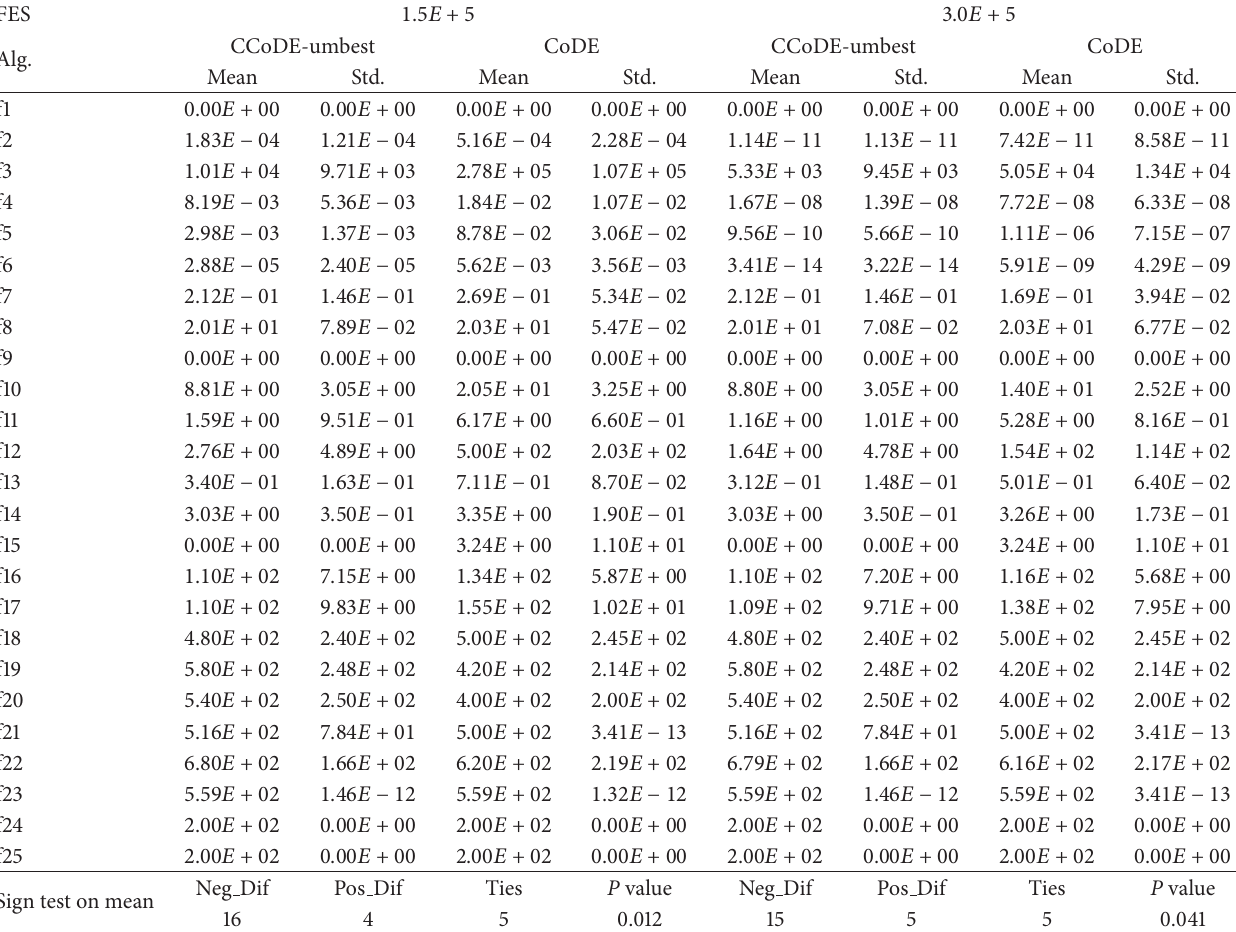
Table 4: The function error values achieved via CCoDE-umbest and CoDE on CEC2005’s test functions. FES 1.5𝐸 + 5 3.0𝐸 + 5 CCoDE-umbest CoDE CCoDE-umbest CoDE Alg.